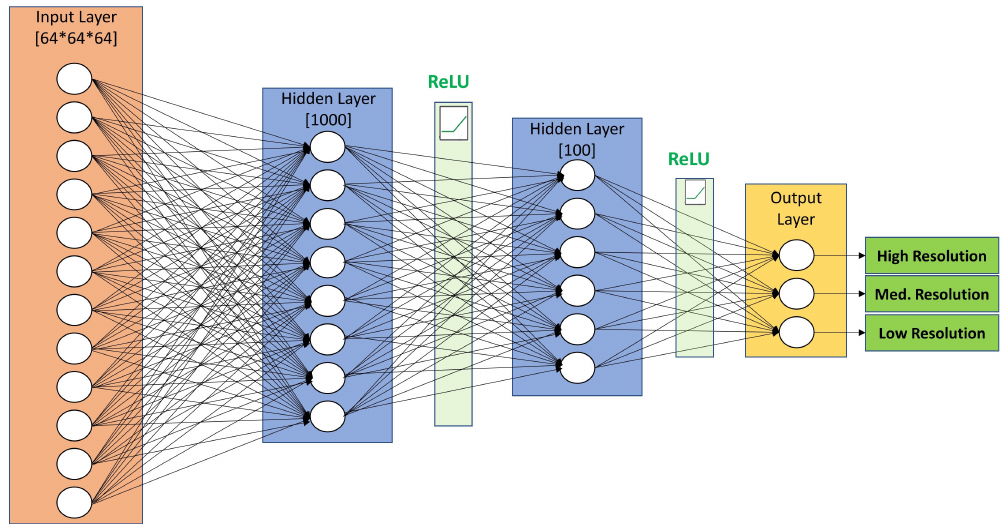
Figure 7. The fully connected neurons in the DNN Architecture and the application of non-linear mapping functions transform an input map into a single label corresponding to high, medium and low